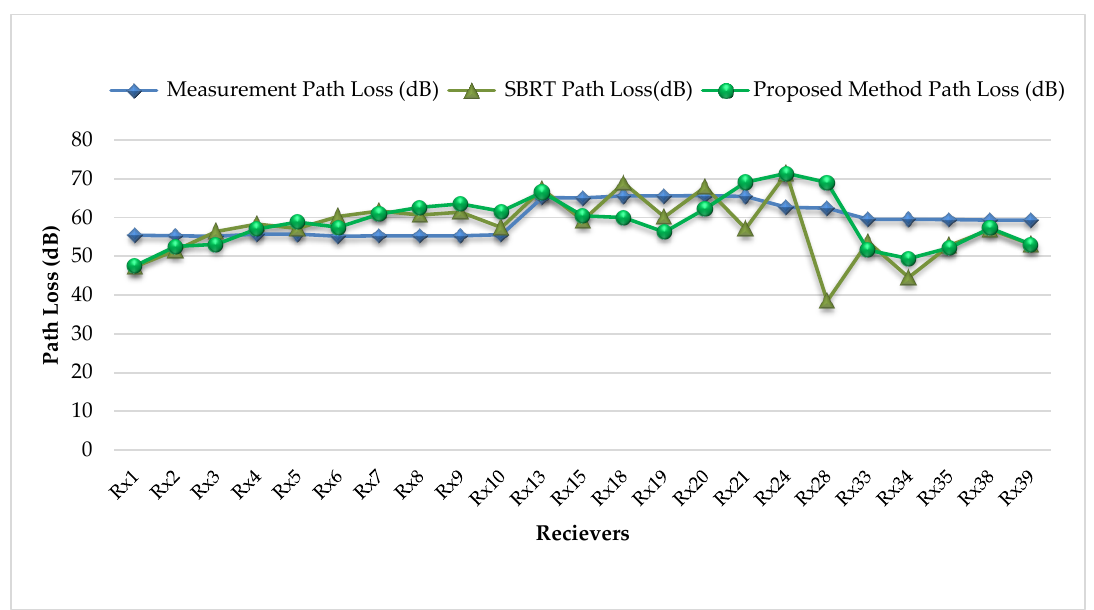
Figure 6. Path loss comparison graph between measurement and SBRT, proposed method simulation.